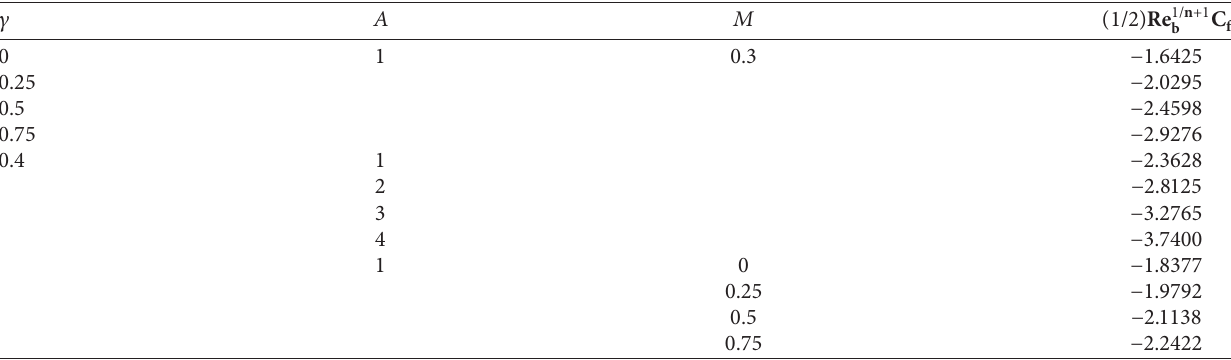
Table 3: Friction coefficient for A, c , and M for n � 1 .